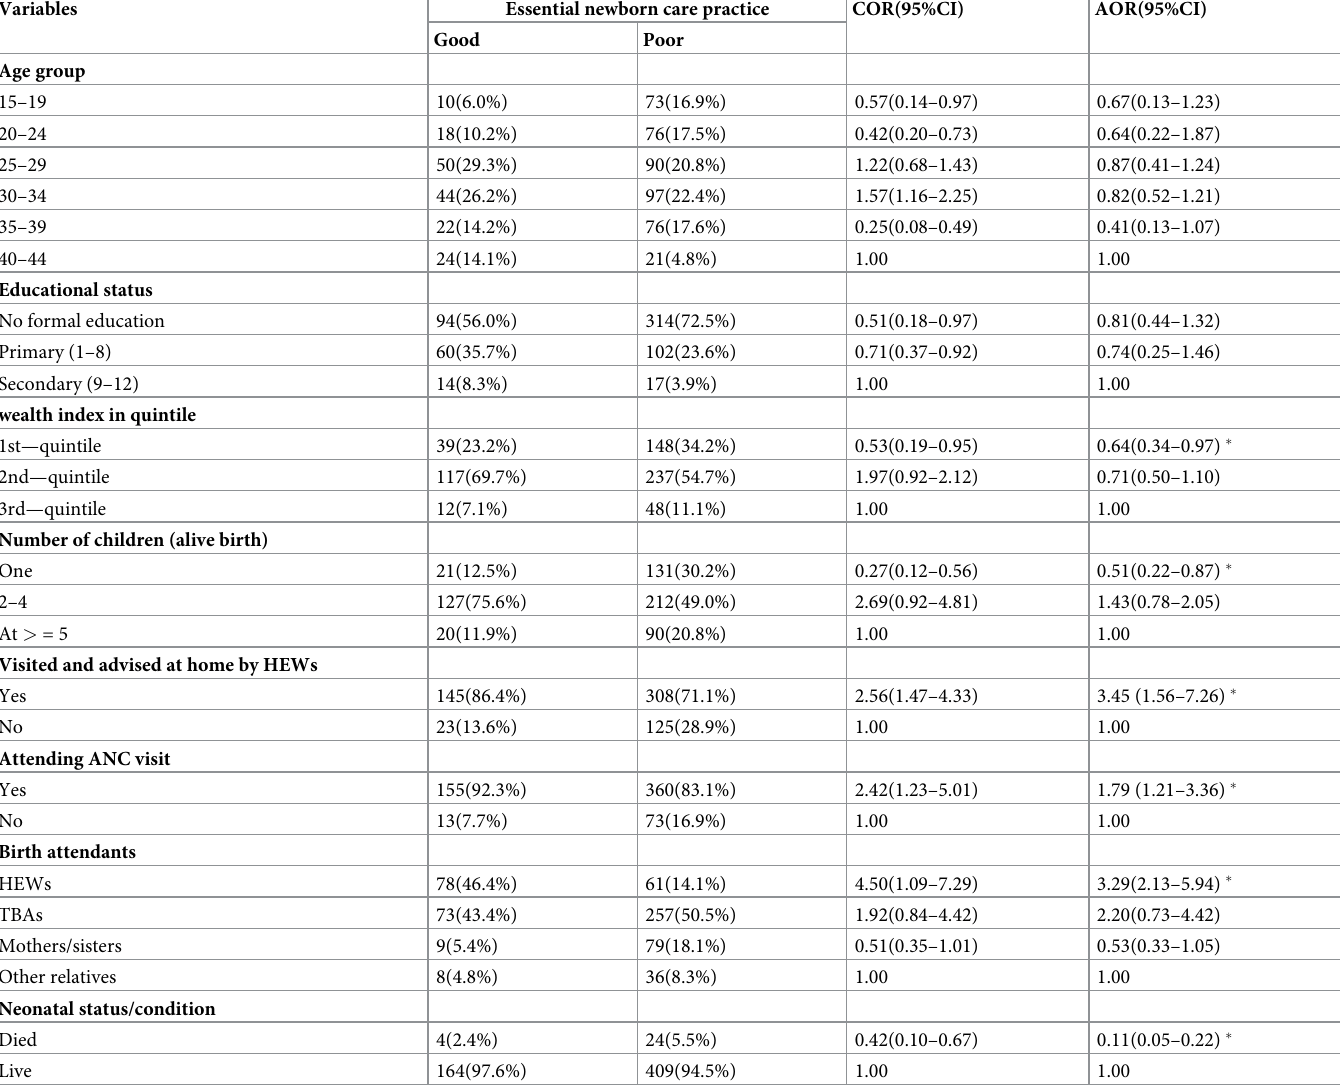
Table 8. Multivariable logistic regression analysis results showing the predictors of ENCP among home delivery women, in Guto Gida district, Oromia regional state, Ethiopia,